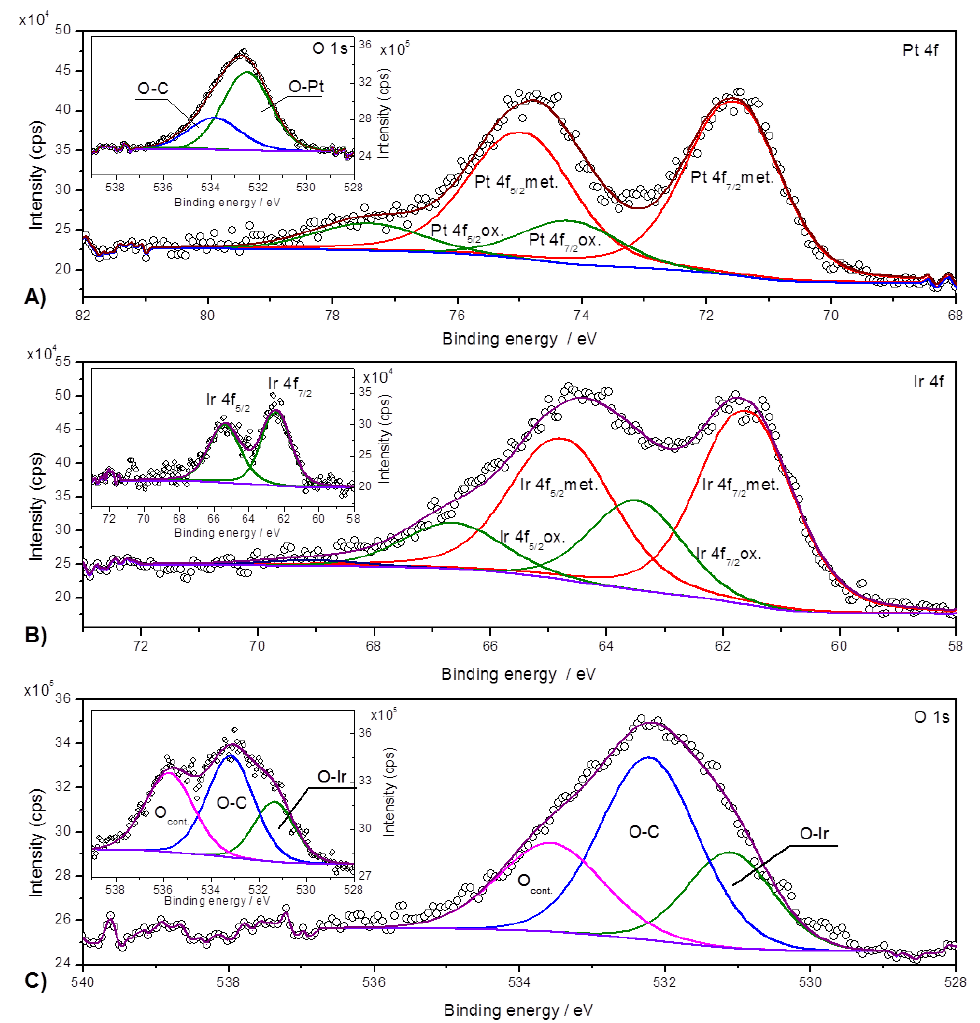
Figure 3. X-ray photoelectron spectroscopy (XPS) spectra of the Pt 4f and O 1s regions recorded for ( A ) Pt / rGO, ( B ) Ir 4f and ( C ) O 1s regions recorded for the Ir / CNT. Insets to panels ( B , C ) present the Ir 4f and O 1s regions recorded for 2%-Ir control sample.